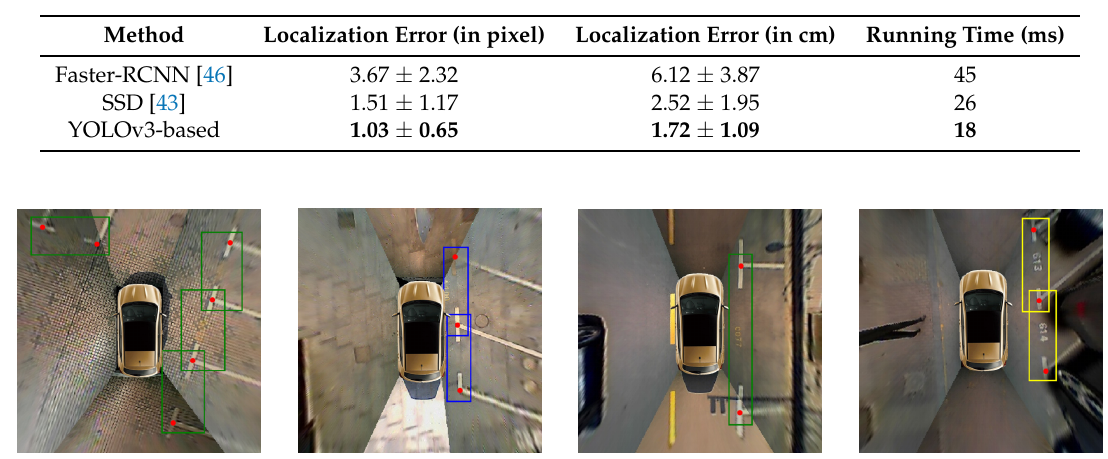
Figure 12. Detection results by YOLOv3-based detector. The green bounding box indicates the “right-angled head”. The blue bounding box indicates the “acute-angled head”. The yellow bounding box indicates the “obtuse-angled head”. The red dot indicates the “marking